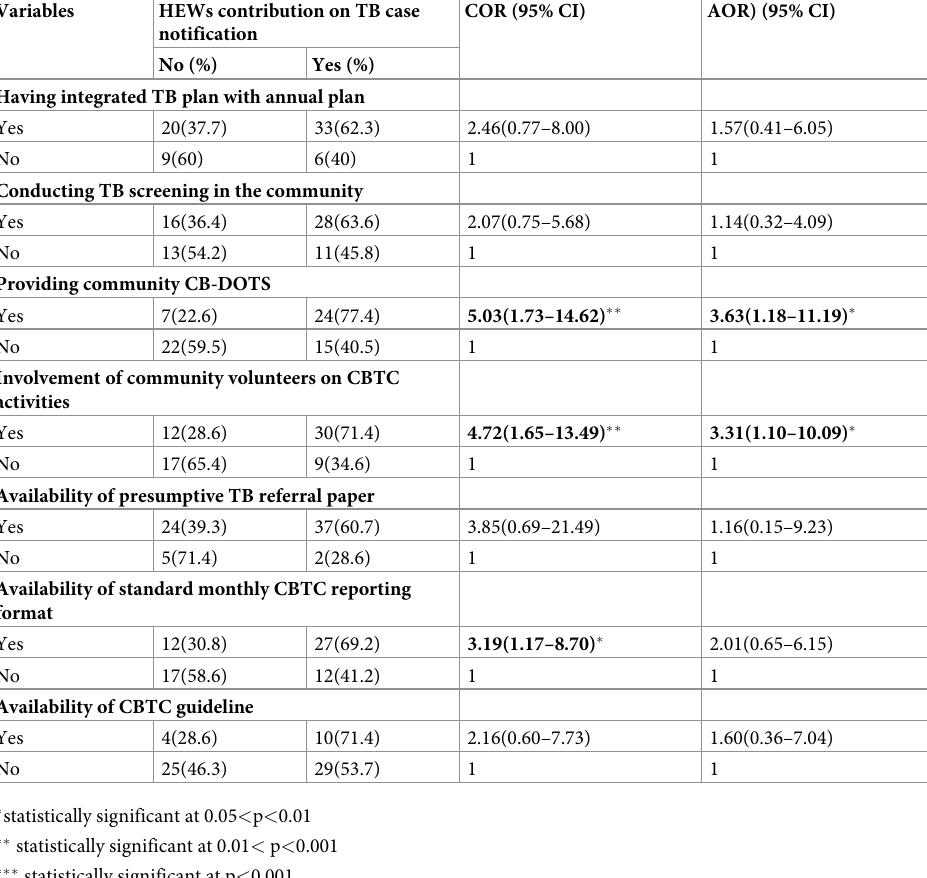
Table 3. Logistic regression analysis of selected variables with HEWs contributions on TB case notification in Tigray region, Northern Ethiopian, 2019 (N = 68).